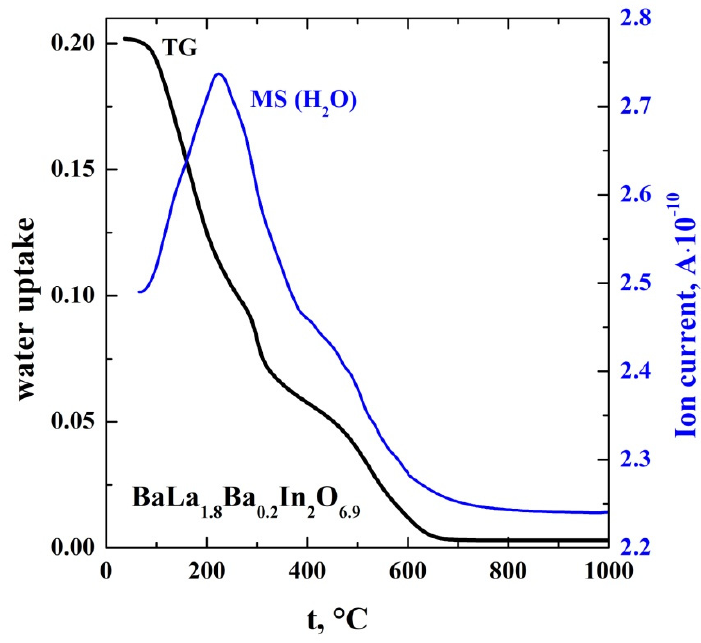
Figure 3. The TG and MS(H 2 O) curves of BaLa 1.8 Ba 0.2 In 2 O 6.9 · 0.2H 2 O composition.